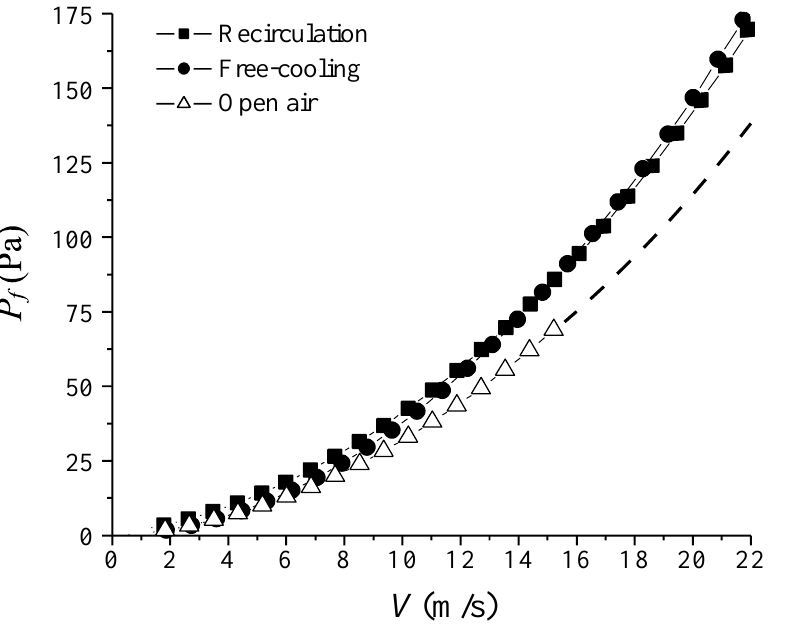
Figure 12. The forward stagnation pressure P f of the first carriage in the two ventilation modes and in the open air.